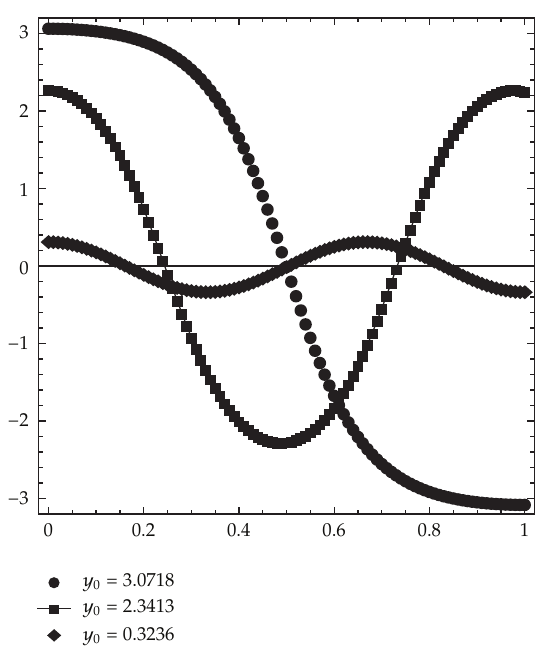
Figure 5: Solution of (cid:2) 1.2 (cid:3) corresponding to the initial values y 0 for 9 π 2 ≤ λ (cid:5) 90 < 16 π 2 .